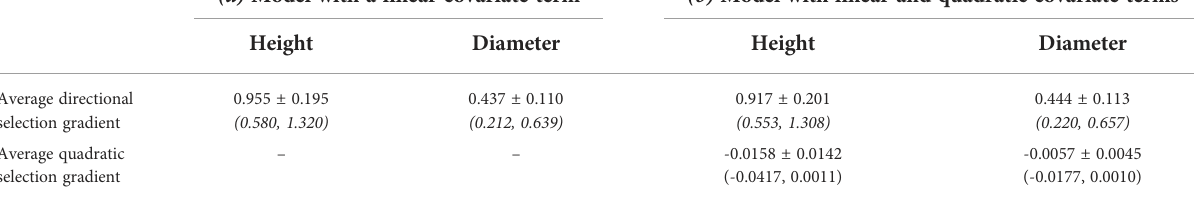
TABLE 3 Relationship of tree survival with growth performance measures (height or diameter), assessed in a common-garden fi eld trial of E. pauci fl ora . (a) Model with a linear covariate